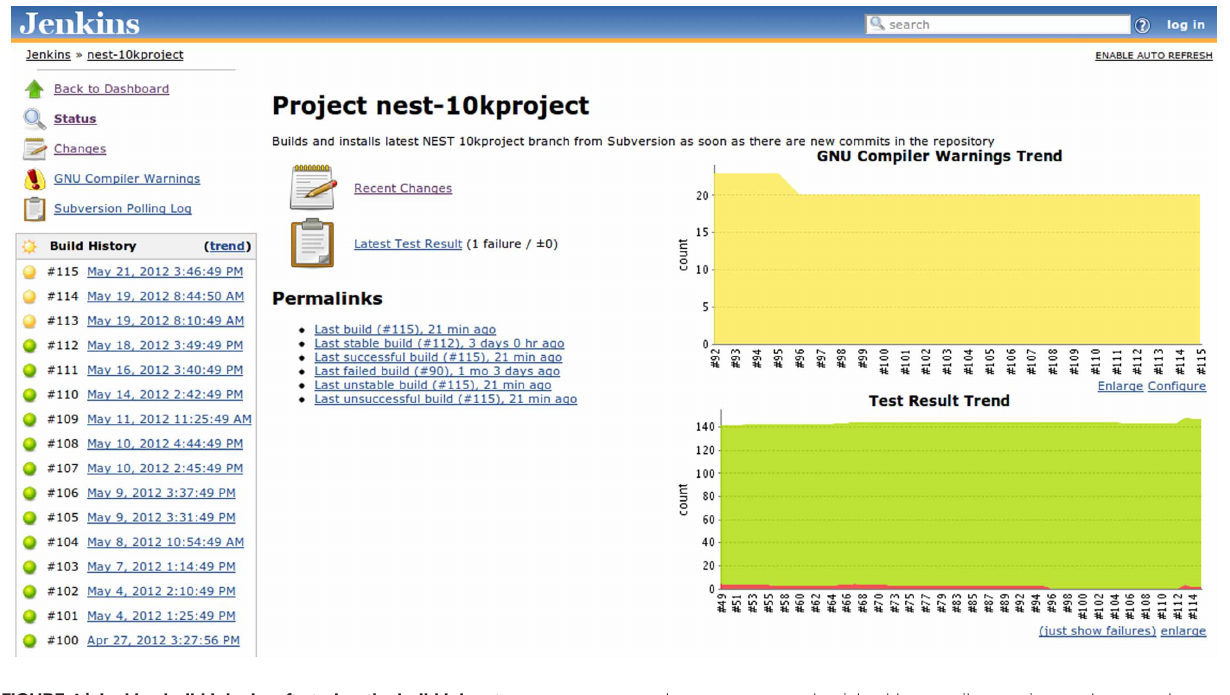
graphs are present on the right side: compiler warnings and test result trends. The compiler warnings graph shows the evolution of the number of warnings over time, but does not discriminate particular kinds of warnings. The test result graph shows the proportion of failing tests (red area stacked under the green one) over the past 65